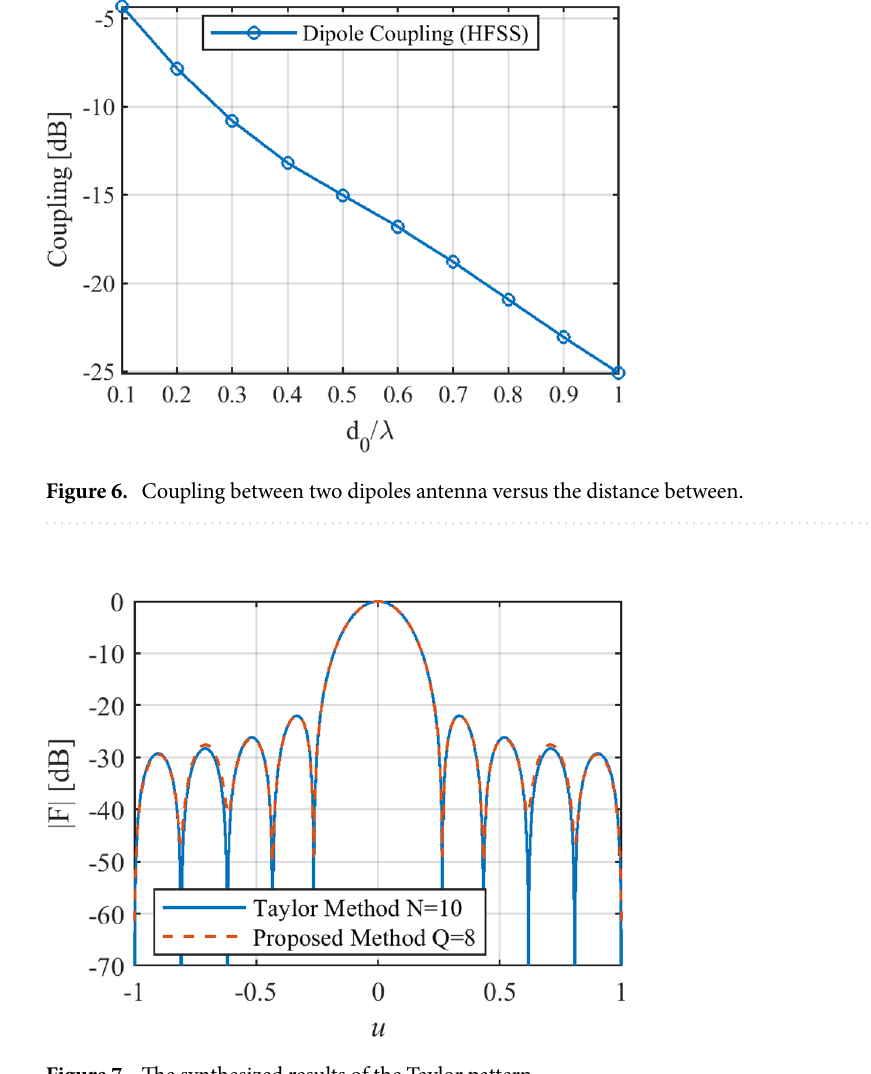
Figure 7. The synthesized results of the Taylor pattern.